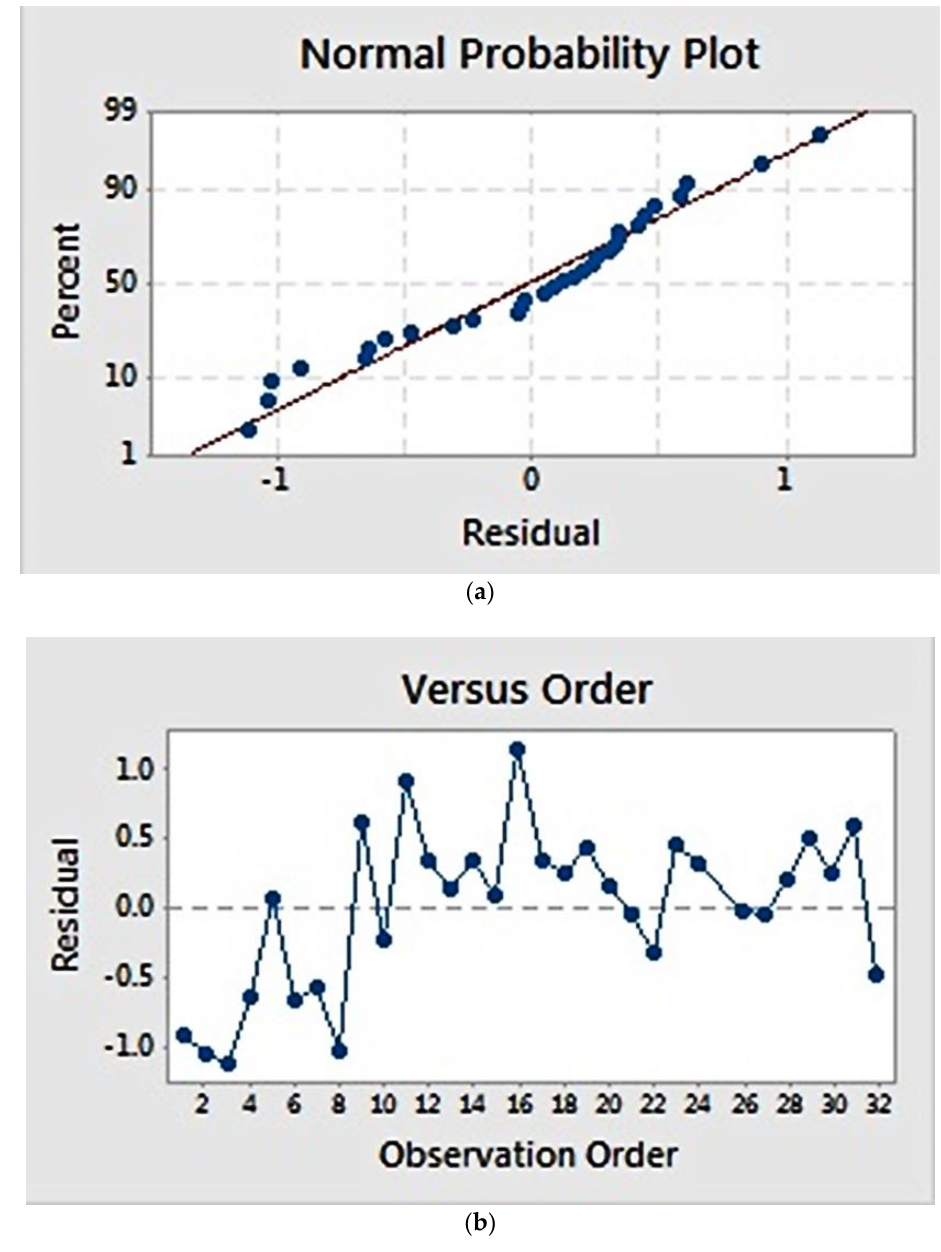
Figure 2. Residual plot for fibre diameter: ( a ) normal probability plot, showing a linear correlation; ( b ) residuals versus observation order, showing a random correlation.